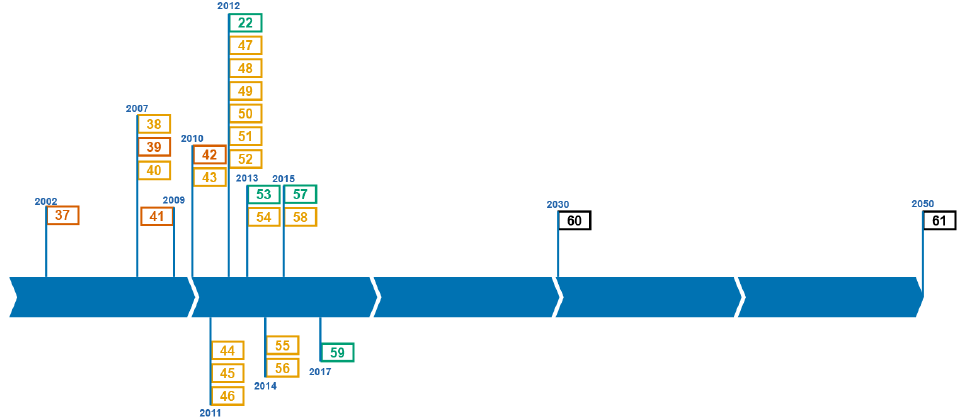
Figure 5. Distribution of temporal position in studies of single events